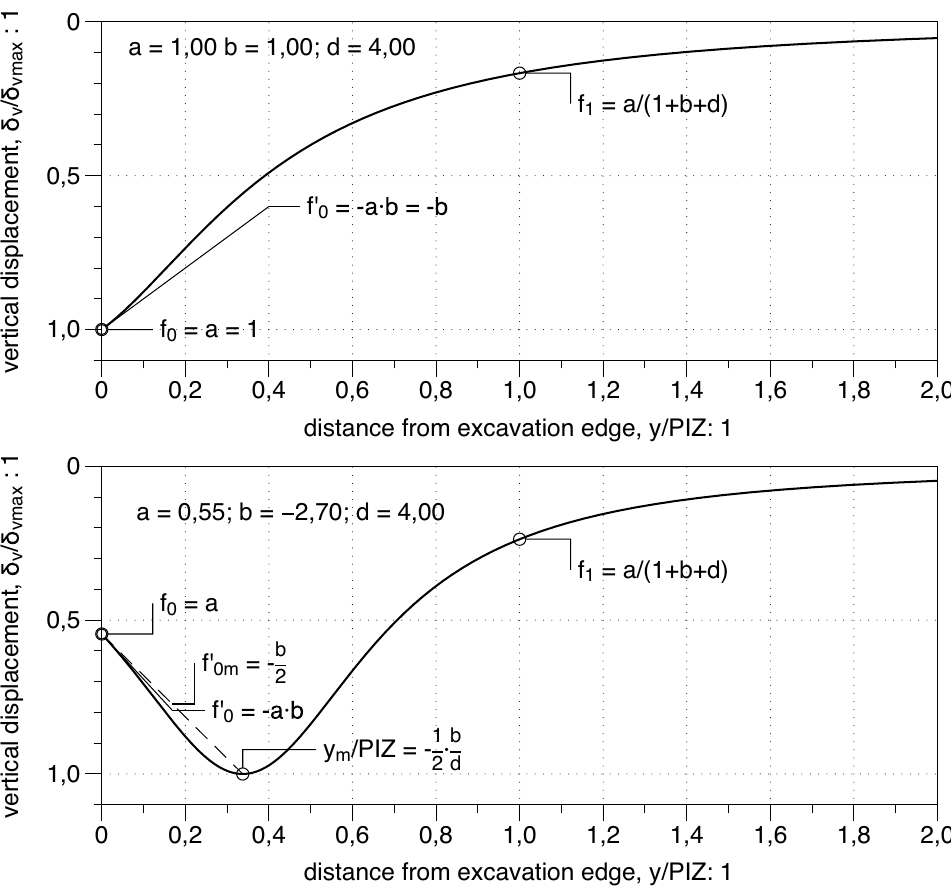
Figure 2. Settlement profiles in the direction normal to the wall as described by the new shape function.